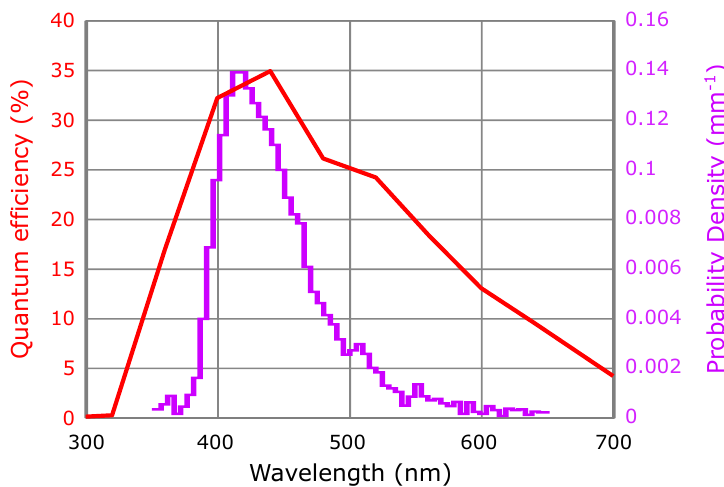
Figure 4. (Red) The quantum efficiency spectrum of the Photonis image intensifier used in this work, as measured by the manufacturer. (Purple) The TPB emission spectrum, adapted from [26].